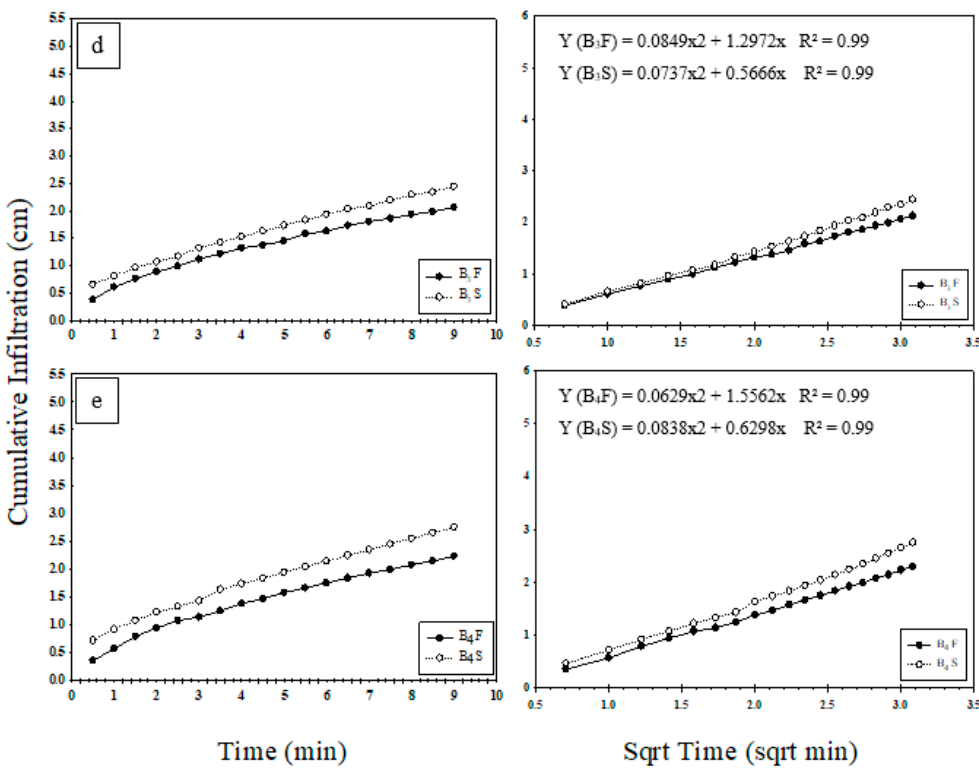
Figure 2. (a–e) Effects of soil conditioners(biochar) applications on C.I. C denotes the control soil and B denotes the soil with biochar application rates of 1, 2, 3, and 4. F and S denote fresh and saline water, respectively.